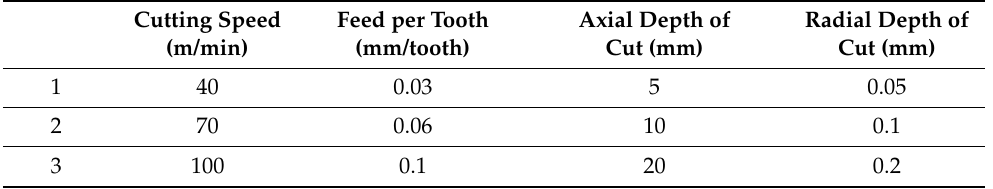
Table 4. Machining parameters.